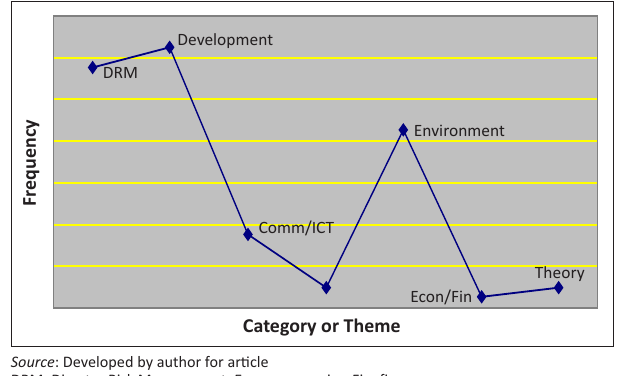
FIGURE 1: Content analysis of themes covered by Jàmbá